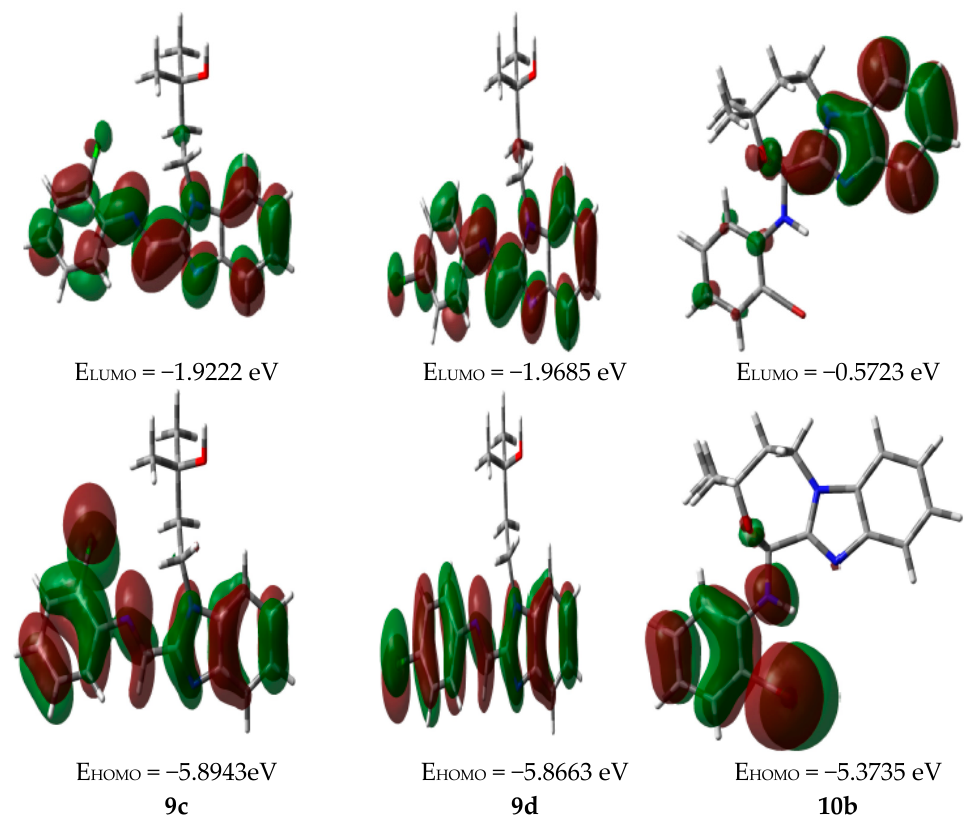
Figure 6. The ground state isodensity surface plots for the frontier molecular orbitals.